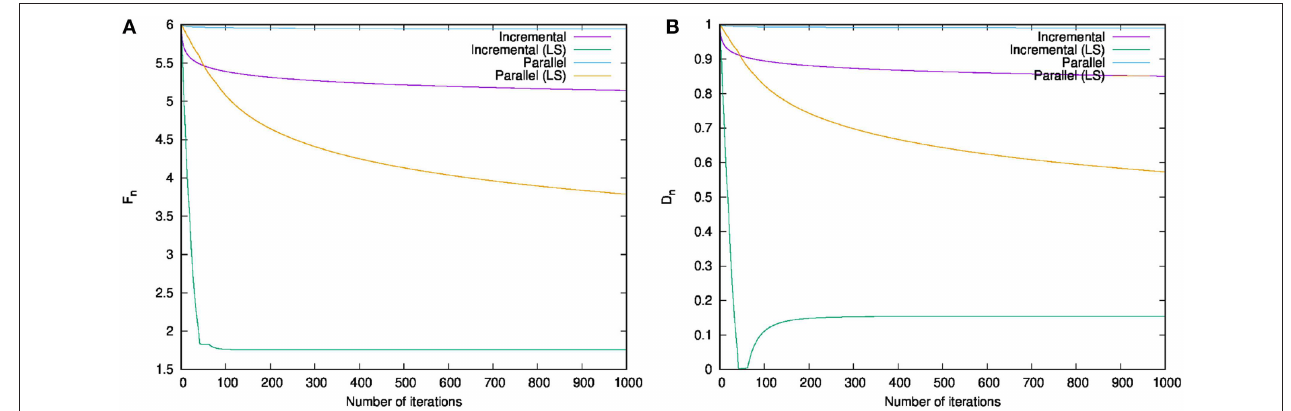
FIGURE 1 | Numerical comparison of running the existing and proposed algorithms on the test problem 1. (A) Behavior of F n in each iteration n . (B) Behavior of D n in each iteration n